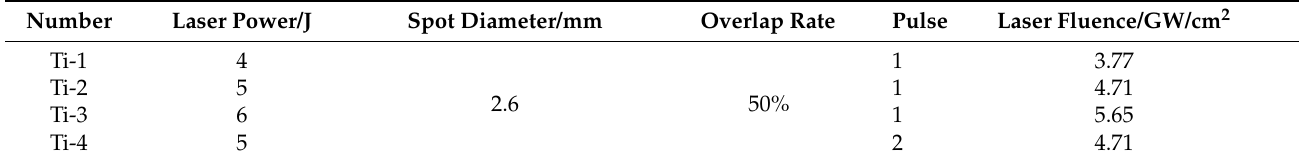
Table 2. LSP processing parameters for TC6 titanium alloy samples.